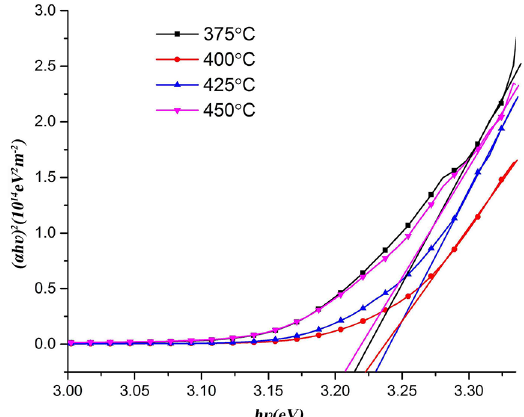
Figure 13. The dependence of (αhν) 2 on photon energy E (=hν) for different temperatures, from which the optical band gap (E